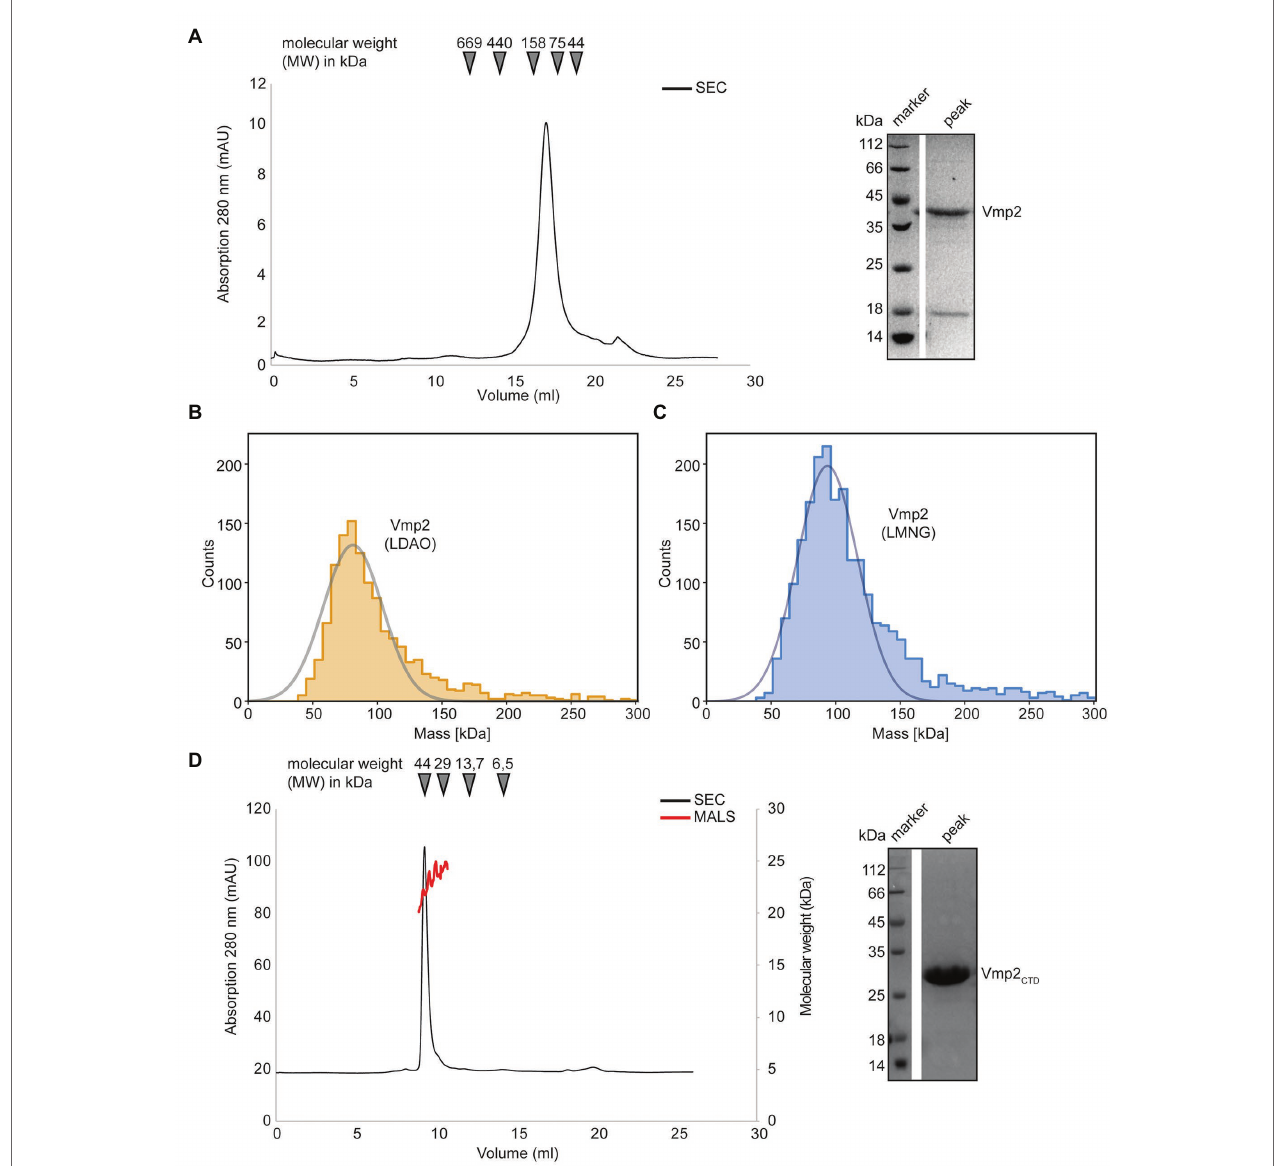
FIGURE 6 | Biochemical analysis of Vmp2. (A) SEC chromatogram of full length Vmp2. The inset shows a SDS-PAGE of the peak fraction. (B) Mass photometry of Vmp2 in 0.1% LDAO. (C) Mass photometry of Vmp2 in 0.001% LMNG. (D) SEC-MALS shows that the C-terminal domain (CTD) of Vmp2 (aa 120–335) is monomeric with an apparent molecular weight (MW) of 24 kDa. The black line depicts the absorption at 280 nm, while the red line corresponds to the molecular weight as determined by MALS. The inset shows a SDS-PAGE of the peak